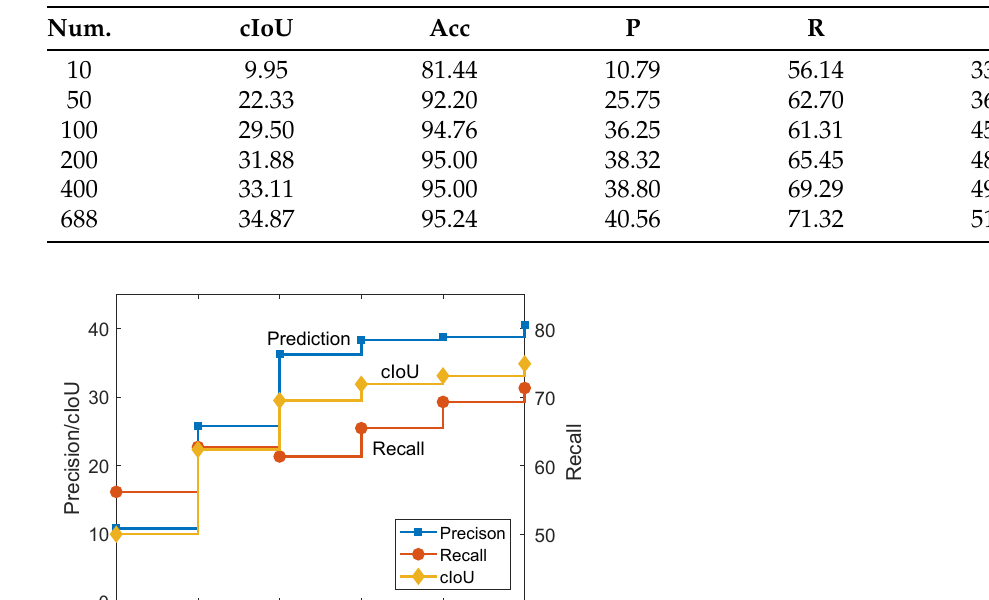
Table 4. Ablation study for dataset scale.